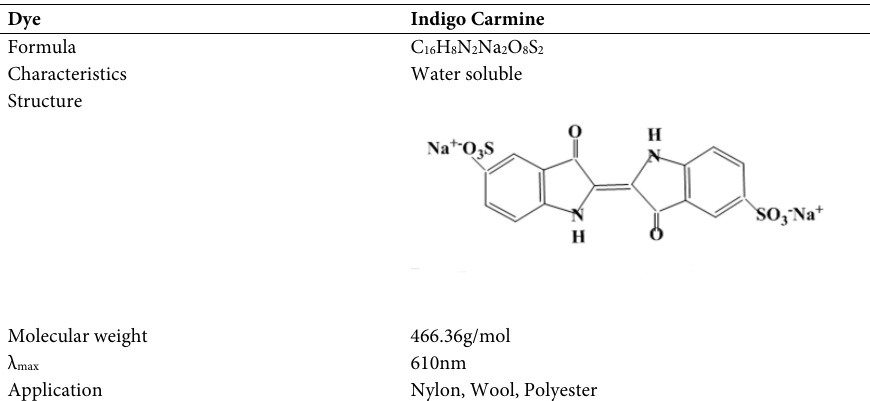
Nylon, Wool, Polyester